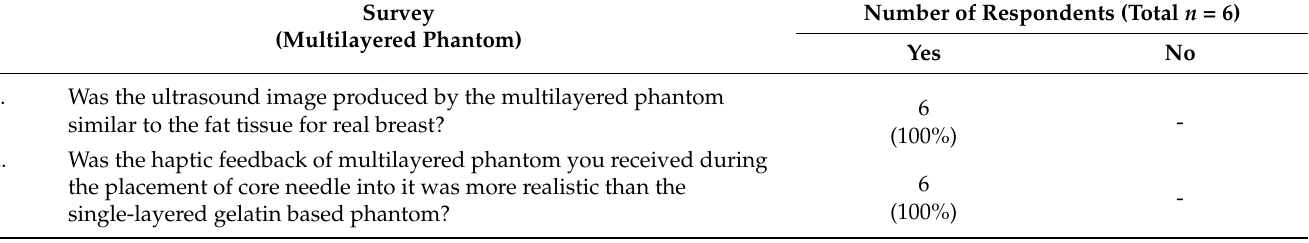
Table 5. Survey on multilayered gelatin-based breast phantom.